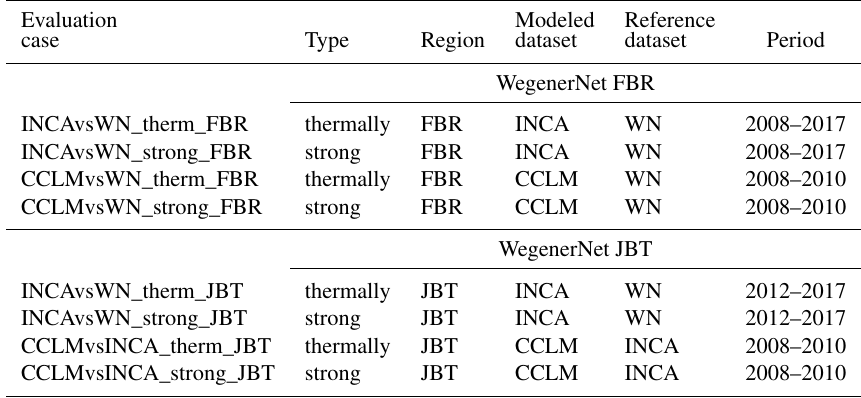
Table 1. Characteristics of wind field evaluation cases used for the WegenerNet, INCA, and CCLM intercomparisons (top half for the WegenerNet FBR; bottom half for the WegenerNet JBT region).